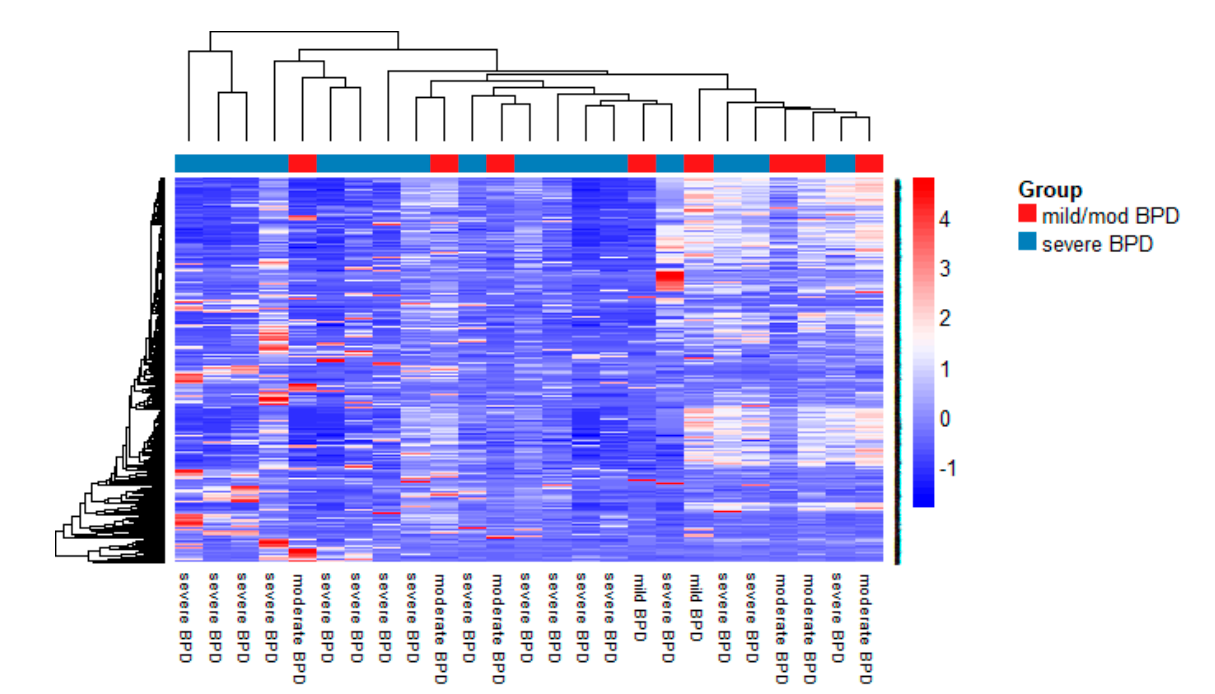
Figure 2. Heatmap of expression of 1048 miRNAs in tracheal aspirates from mild/moderate ( n = 8) and severe ( n = 17) BPD infants (normalized by global mean), obtained by PCR arrays. Heatmap generated in R using the NMF package as described in Section 2.